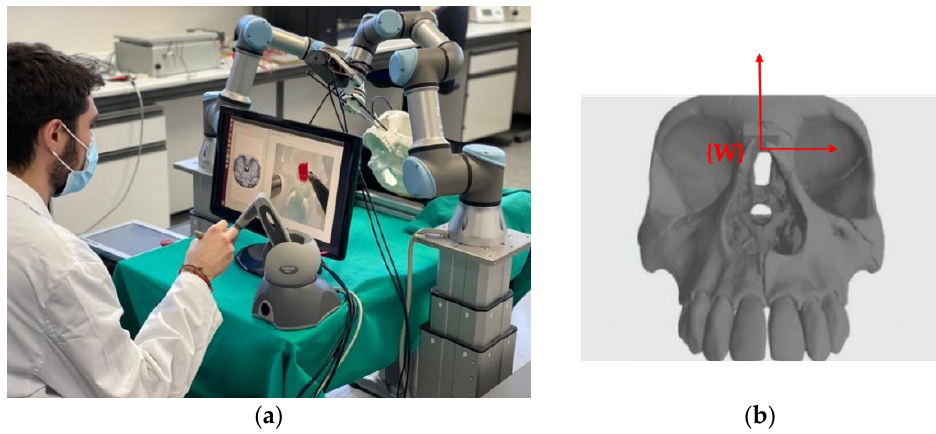
Figure 6. ( a ) Endonasal surgery setup. ( b ) Reference system in the 3D model of the skull.